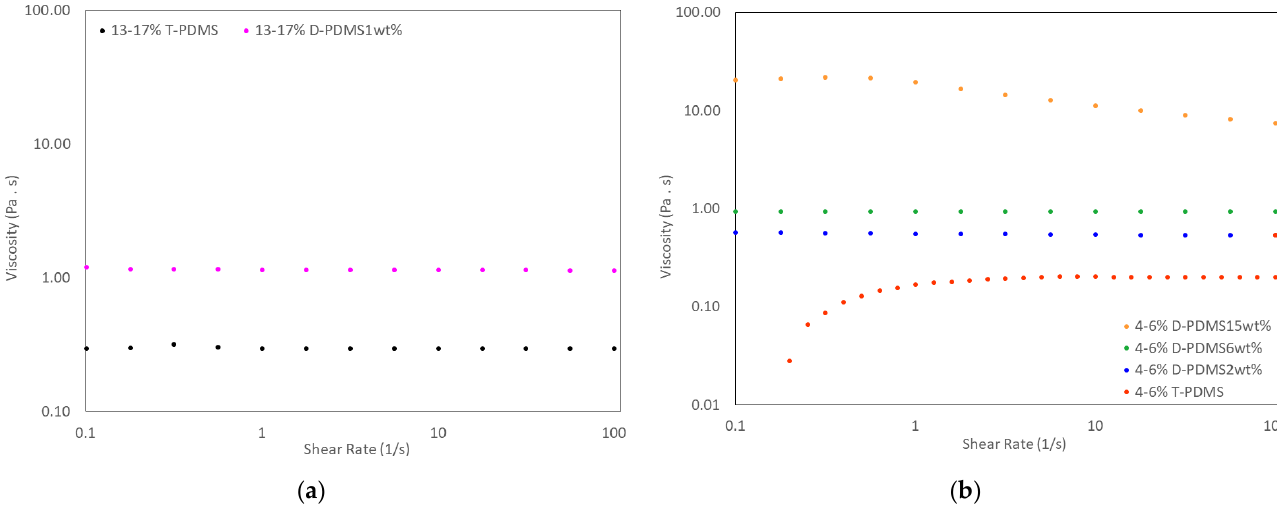
Figure 6. Flow curves of ( a ) 13 – 17% T-PDMS and its liquid product, 13 – 17% D-PDMS 1wt% ( b ) 4 – 6% T-PDMS and its liquid 4 – 6% D-PDMS products.